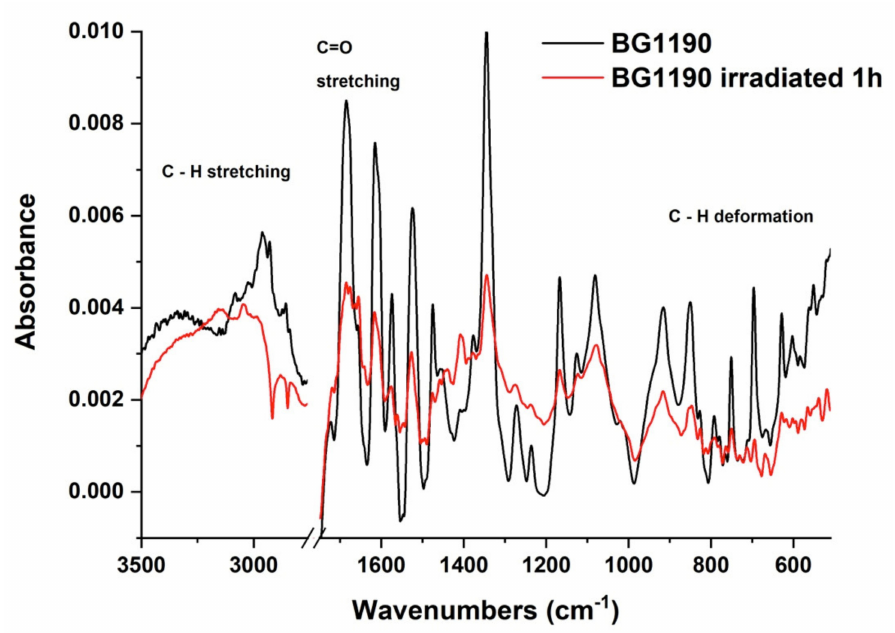
Figure 8. FTIR spectra of the unirradiated and 1 h irradiated BG1190 10 − 3 M solutions in